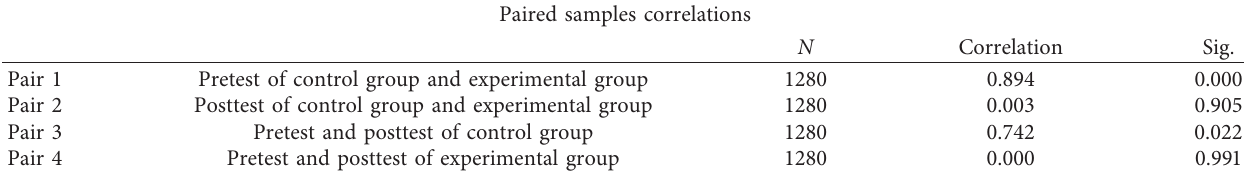
Table 3: Paired samples correlations.